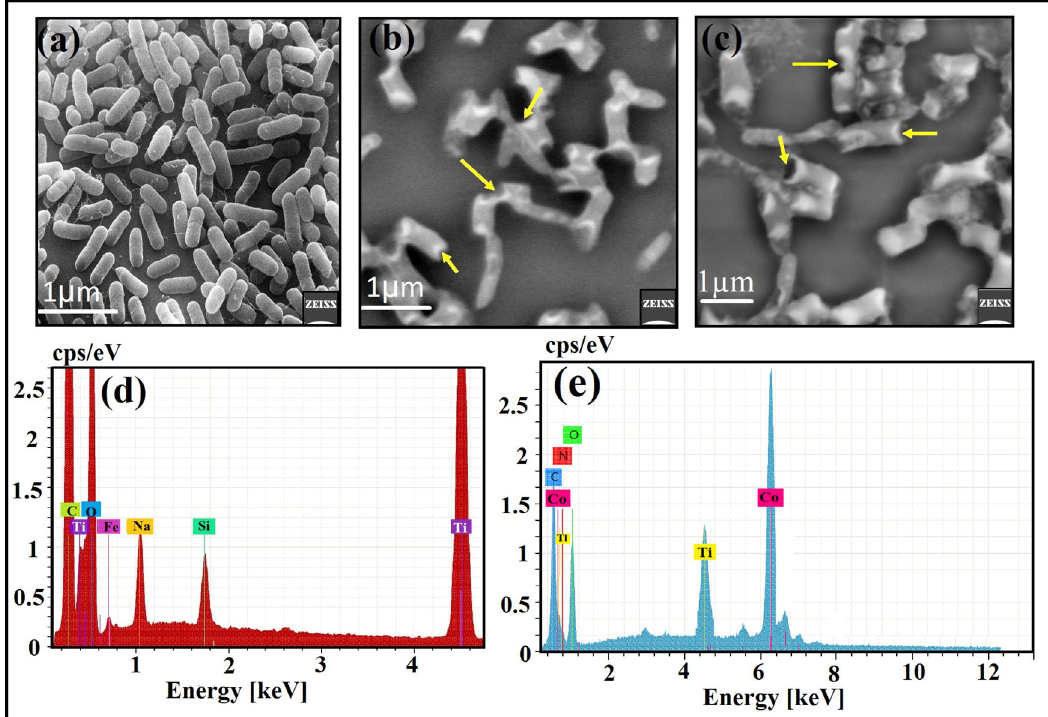
Figure 7. SEM and the matching EDX elemental study of P. aeuroginosa : ( a ) Regular bacterial cells ( P. aeuroginosa ) without TiO 2 mesocrystals, and Co-doped TiO 2 mesocrystals treatment, ( b ) Abnormal, deformed and irregular bacterial cell with incomplete lysis following TiO 2 mesocrystals treatment, ( c ) Fully-irregular and deformed bacterial cell through Co-doped TiO 2 mesocrystals treatment presenting the full lysis of P. aeuroginosa cell, ( d ) Matching EDX elemental study of the treated P. aeuroginosa cell validating the cellular internalization of the qualified TiO 2 mesocrystals in P. aeuroginosa cells, and ( e ) Matching EDX elemental examination of the treated P. aeuroginosa cell establishing the cellular internalization of the integrated Co-doped TiO 2 mesocrystals in P. aeuroginosa Co-doped TiO 2 mesocrystals suppressed the growth of P. aeruginosa by more than 98% with 0.39 µg/mL MIC as listed in Supplementary Table S2. Figure 5 shows a summarized diagram regarding the antibiofilm potential of Co-doped TiO 2 mesocrystals (as inhibition %) against different pathogenic microbes. Antimicrobial effect of Co‑doped TiO in liquid media under illumination. The comparison 2 between the inhibition% of P. aeruginosa , S. aureus , and C. albicans upon the use of TiO 2 and Co-doped TiO 2 mesocrystals and UV are presented in Fig. 6. Note that Co-doped TiO 2 showed higher antimicrobial activities against P. aeruginosa, S. aureus, and C. albicans colonies than pure TiO 2 , Fig. 6b–d, revealing the synergistic actions of Co doping and the TiO 2 mesocrystals. Moreover, upon UV-illumination, Co-doped TiO 2 mesocrys- tals exhibited even higher antimicrobial activities than that in the dark. The maximum inhibition percentage of bare TiO 2 and Co-doped TiO 2 mesocrystals under UV-illumination for P. aeruginosa at the end of the experi- ment was 24.24% and 50.50%, respectively (Fig. 6a,b), while it was 30.31% and 60.25% for S. aureus (Fig. 6c,d), and 39.15% and 55.55% for C. albicans (Fig. 6e,f). The observed activity under light irradiation may be related to the induced oxygen species such as OH free radicals, which caused the destruction of the microbial coenzymes and reduced their contents 19,42 . The major influences involve the creation of holes in the cell wall of the microbes, which subsequently-progressed the cell permeability and finally a cell death will occur. To confirm the induced oxygen species, electron paramagnetic resonance (EPR) spectra were collected as shown in Supplementary Fig. S4. The two samples showed signals at g = 1.95, g = 2.157, g = 2.05, and g = 2.12, confirming the presence of Ti 3+ and free oxygen radicals such as OH . , O .- , or O 2.–68 . Notably, the Co-doped TiO 2 sample showed a higher concentration of paramagnetic centers of 4.16953 × 10 18 spin/g relative to the bare TiO 2 sample (4.09473 × 10 18 spin/g). The increased paramagnetic cent- ers after the addition of cobalt may be related to the increase in the concentration of oxygen radicals in the TiO 6 lattice 57 . This is in agreement with the inhabitation % of Co-doped versus bare TiO 2. SEM/EDX analysis was performed to elucidate the possible antimicrobial mechanism toward P. aeuroginosa , see Fig. 7. The SEM analysis of the control sample in the absence of any mesocrystals showed bacterial groups that incomplete lysis of the outer surface followed by deformations of the P. aeuroginosa cells . Additionally, Co-doped